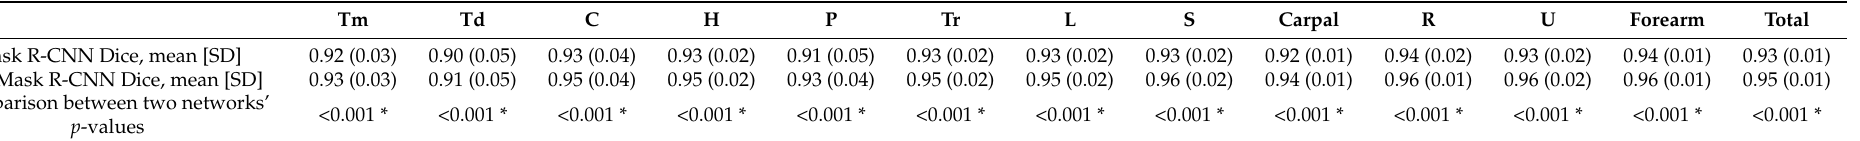
Table 1. Comparison of the performance outcomes between the Mask R-CNN and the Fine Mask R-CNN for the automatic segmentation of ten wrist bones.